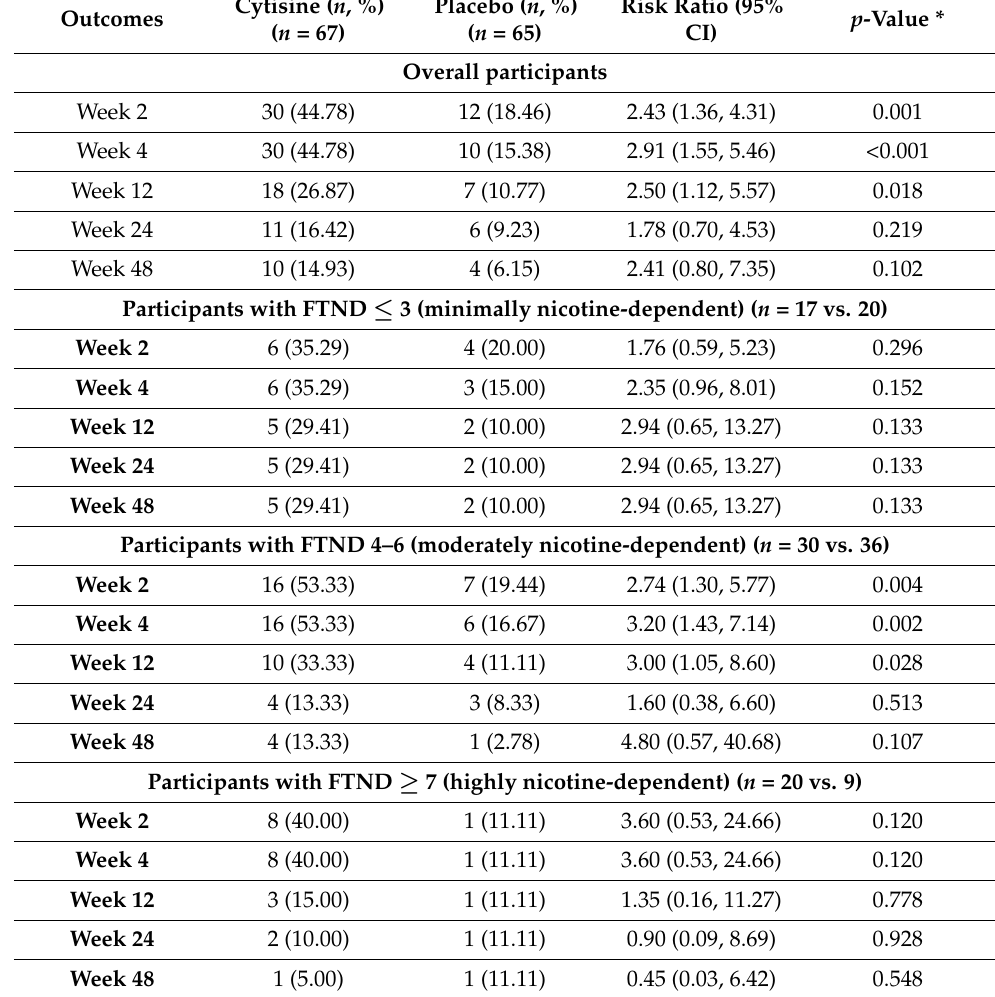
Table 2. Result for continuous